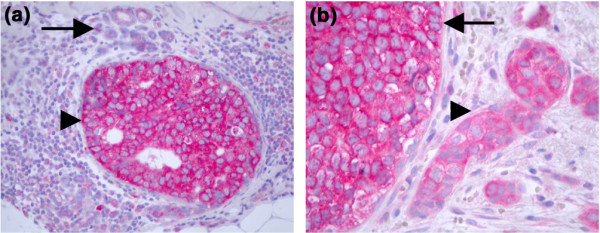
Immunohistochemistry for focal adhesion kinase (FAK) in ductal carcinoma in situ, invasive breast carcinonoma and normal breast tissue. (a) Strongest FAK expression was frequently seen in ductal carcinoma in situ (arrowhead). Notice the missing staining in normal breast tissue (arrow). (b) Invasive breast carcinoma cases (arrowhead) exhibited an equal or less intense FAK immunostaining then adjacent ductal carcinoma in situ (arrow) in all but one case. Original magnification, × 400.